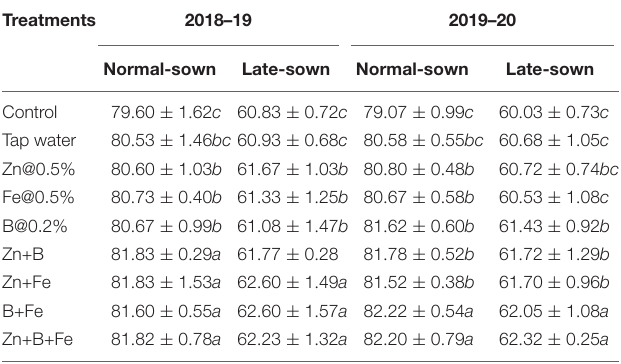
TABLE 4 | Effect of sowing time and zinc, iron, and boron foliar sprays on the relative leaf water content of lentil (%). Treatments